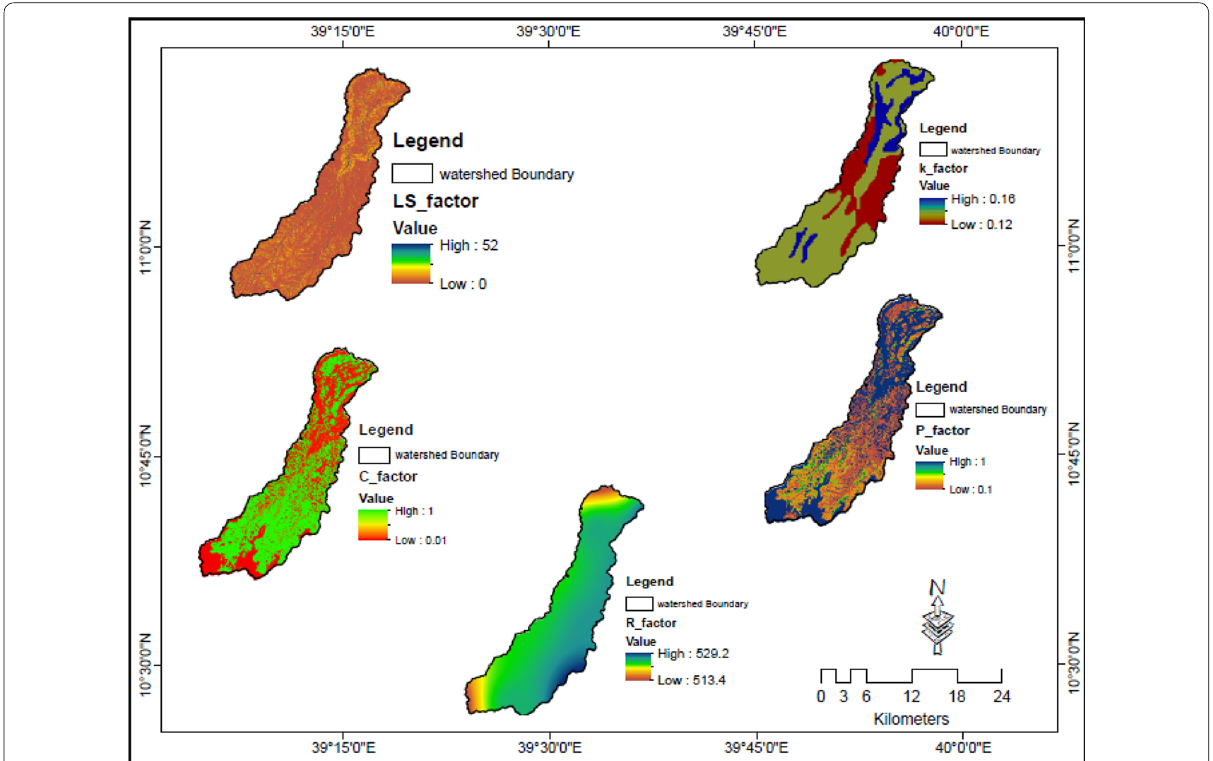
Fig. 7 spatial distributions of LS, K, C, P and R factor on the Gedalas watershed, 2018